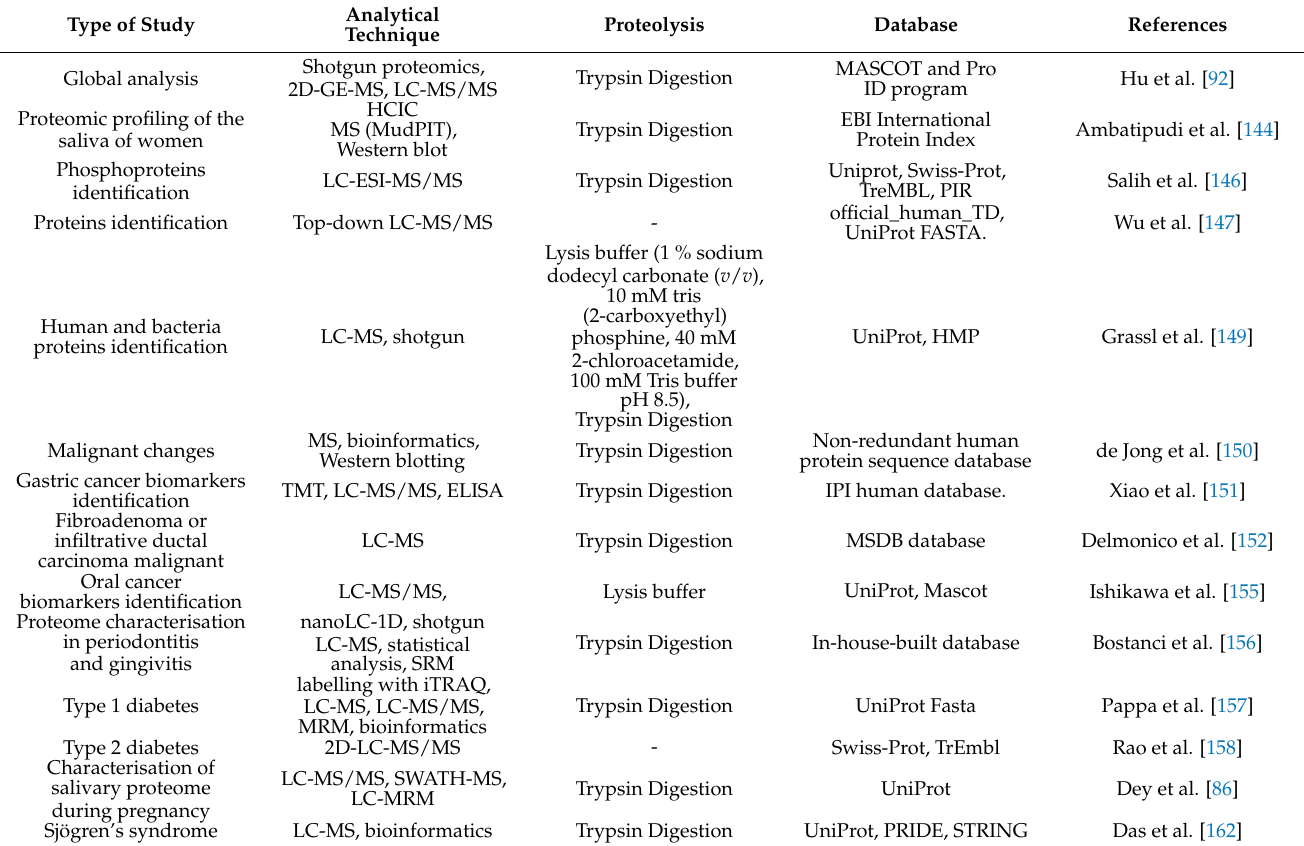
Table 2. Summary of the salivary proteome